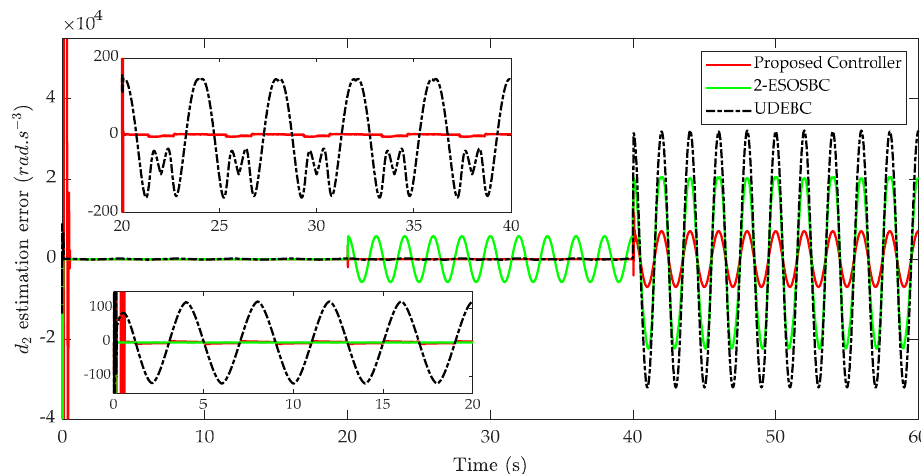
Figure 10. The estimation error of the matched disturbance.